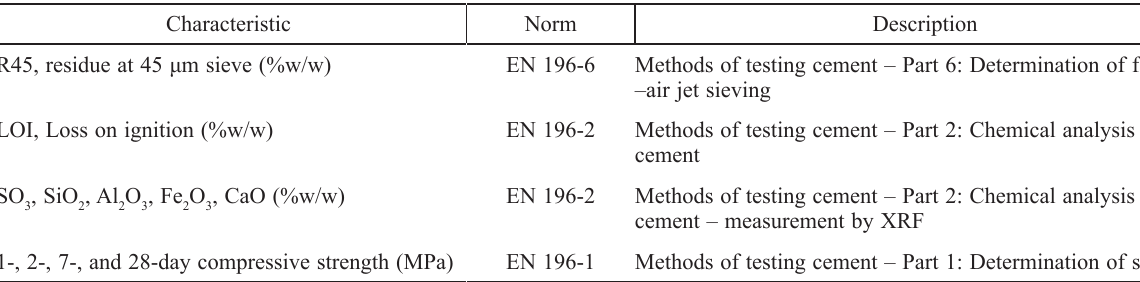
Table 2 – Physical, chemical, mechanical characteristics Characteristic